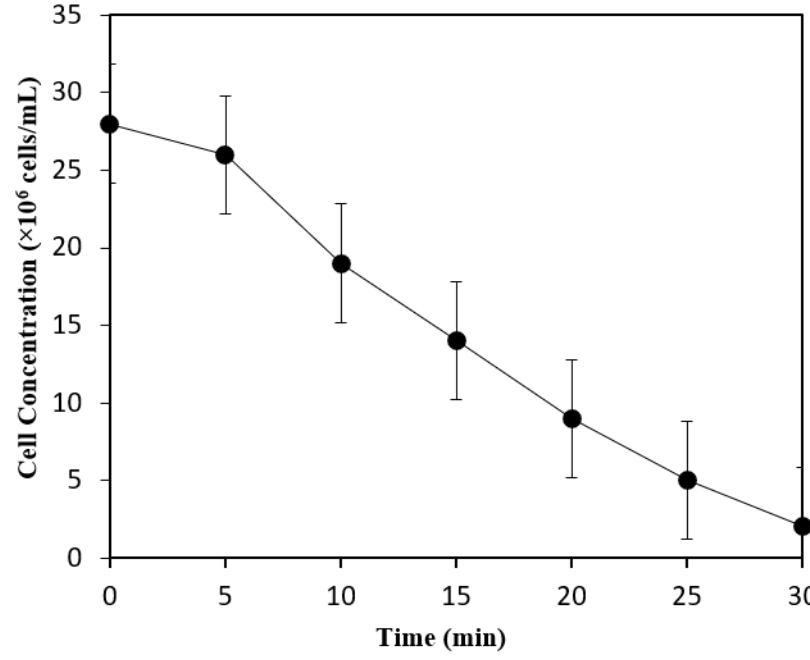
Figure 4. CbCt Cell count after mutagenesis with UV radiation.